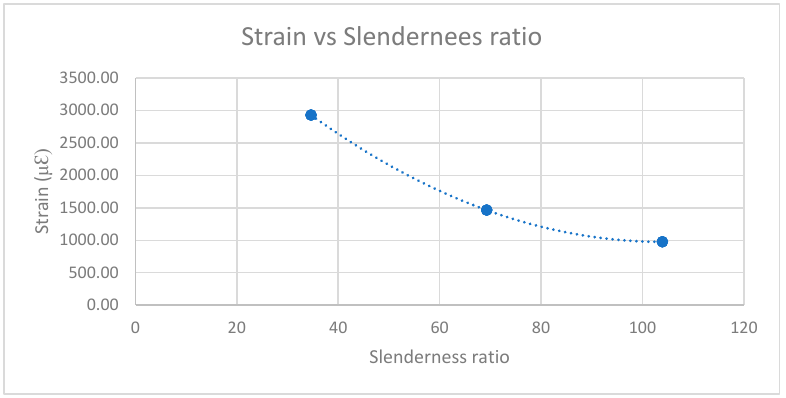
Figure 12. Maximum strain vs. slenderness ratio.